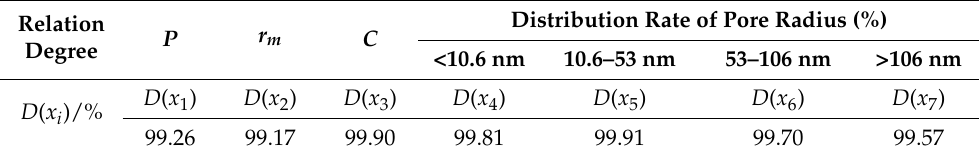
Table 2. Relation degree of Grey Relation Entropy (GRE) (data I).